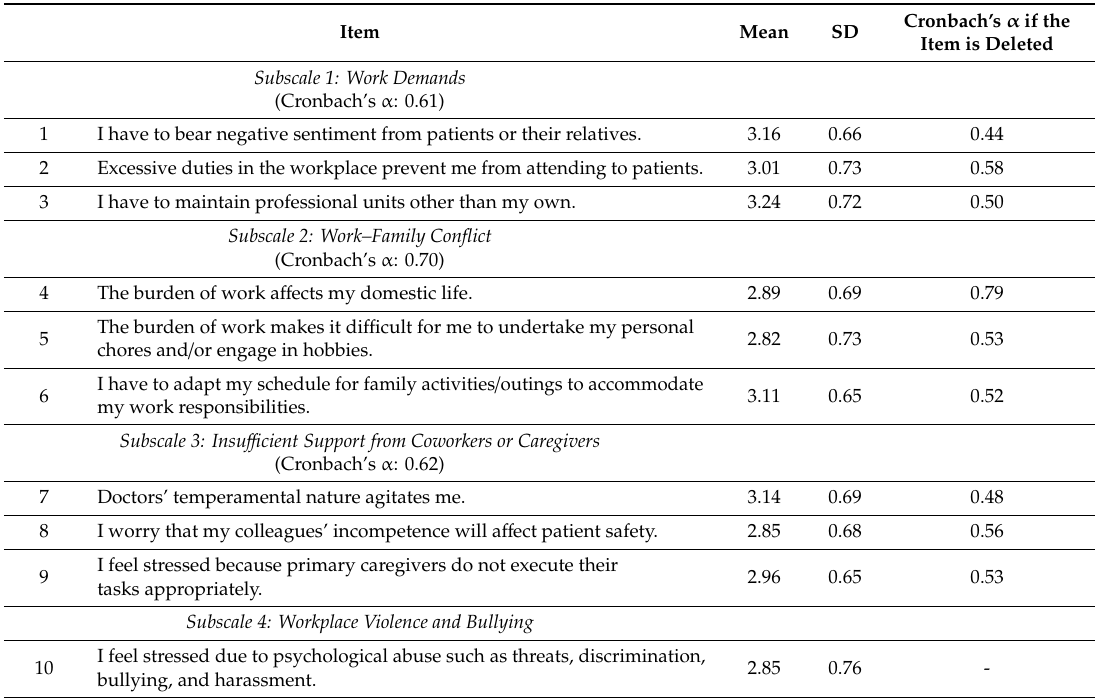
Table 4. Statistics of the 21-item NOSS ( N =